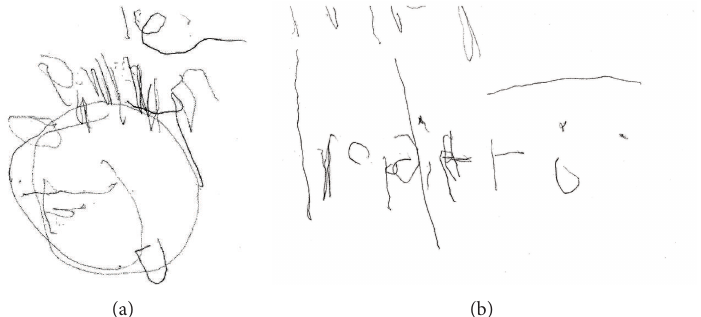
Figure 3: Drawings following verbal commands; a house on the right and a clock on the left.